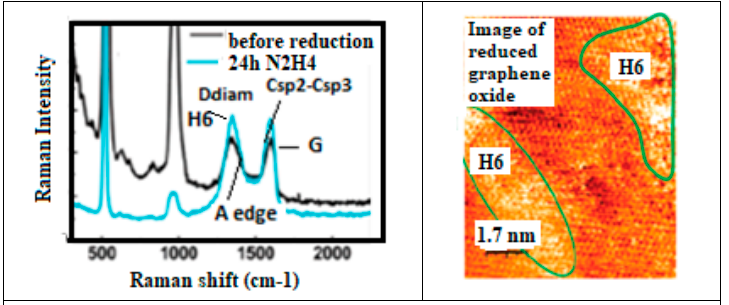
Figure 16. Graphene rippling and local H6 structure formation. Note: Reduced GeA edge after reduction and increase of H6 diamond by C. Gómez-Navarro et al. [236] with permission of the New Journal of Physics.